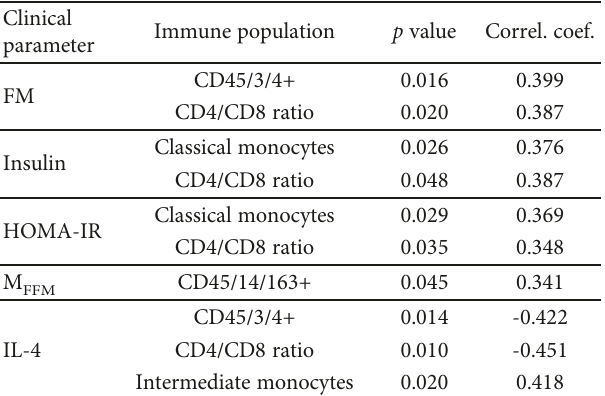
Table 2: Correlations between clinical parameters and circulating immune cells at baseline in all subjects.